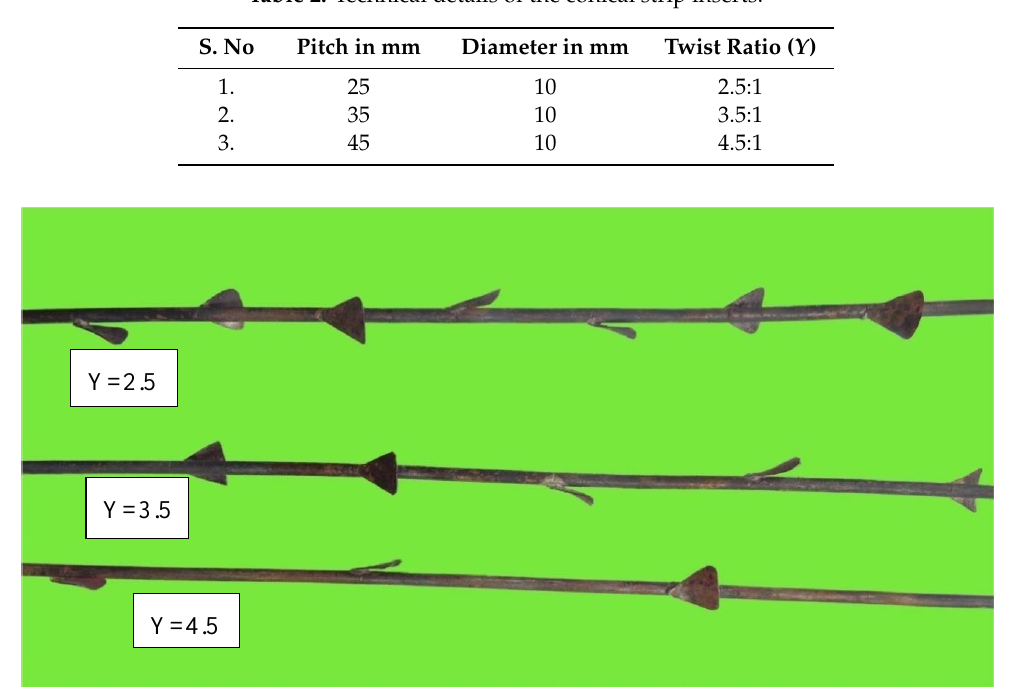
Figure 4. Schematic of the conical strip insert with a forward (FWD) arrangement in the test section. Table 2. Technical details of the conical strip inserts.